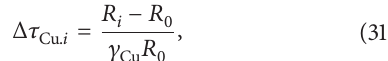
as 1.6 N ⋅ m and 10000 rpm, respectively. The load torque is adjusted by the dynamometer (Magtrol) . The speed was while the same PWM duty ratio was kept as 100%.